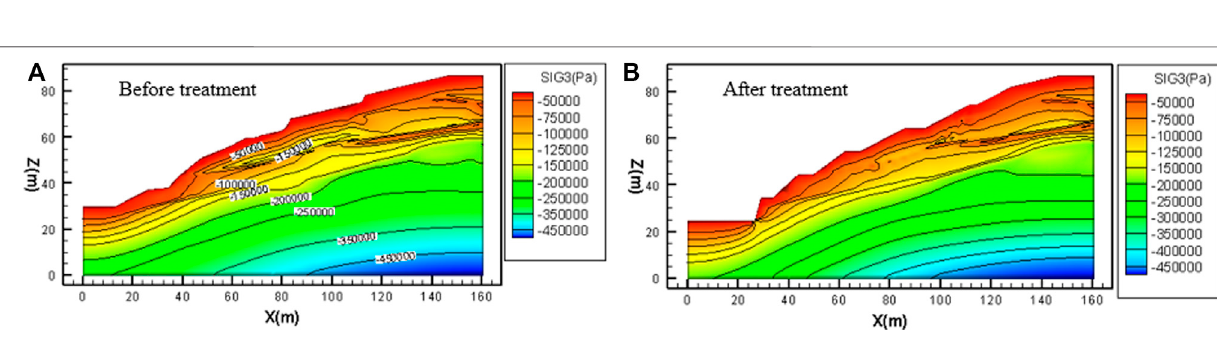
FIGURE 10 | Slope displacement nephogram before and after treatment. (A) : Before treatment, (B) : After treatment.